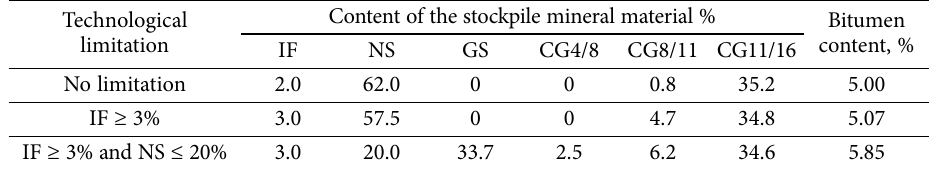
Content of the stockpile mineral material % Bitumen